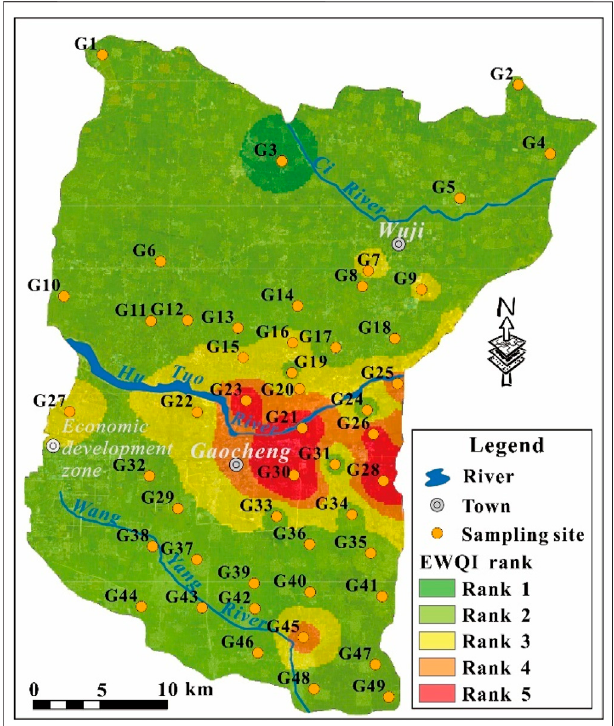
FIGURE 11 | Geospatial distribution of the EWQI water quality rank for the phreatic groundwater in the study area.